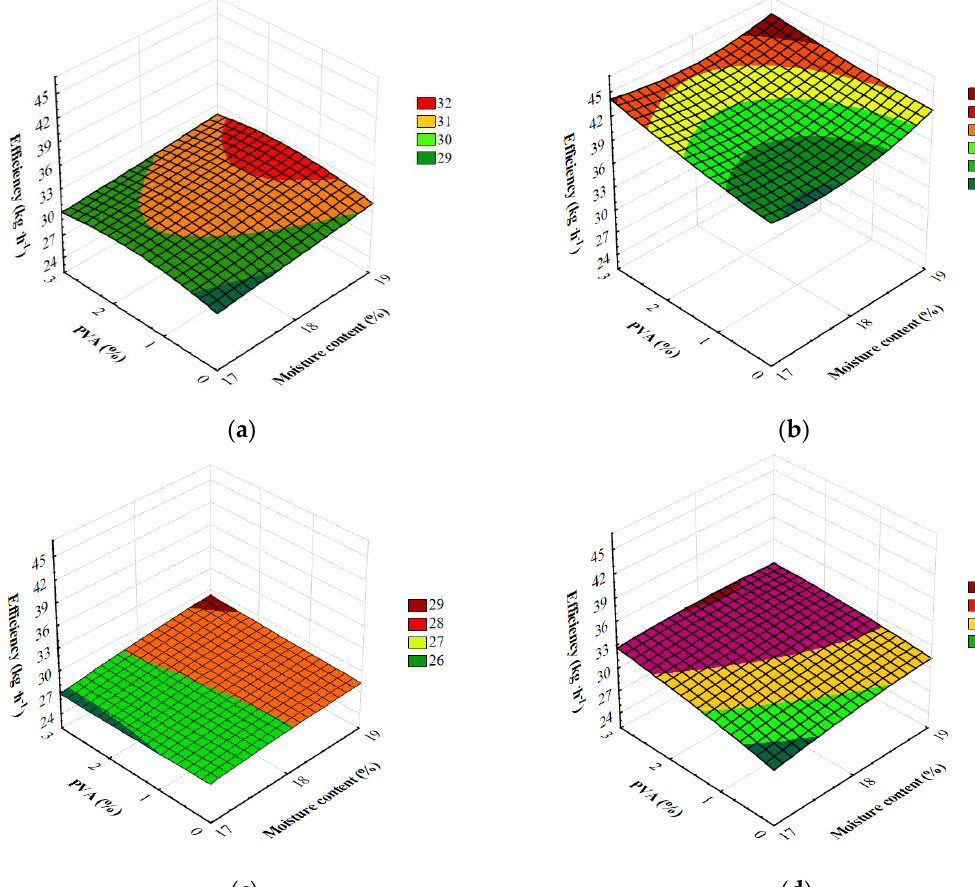
Figure 3. E ffi ciency of starch foams extrusion with various amounts of PVA and the initial moisture content of raw materials processed with di ff erent forming dies at various screw speed: ( a ) M1-S1, ( b ) M1-S2, ( c ) M2-S1 and ( d ) M2-S2. Table 2. Statistical analysis of the e ff ect of variation source and its interactions on starch-based foams processing e ffi ciency